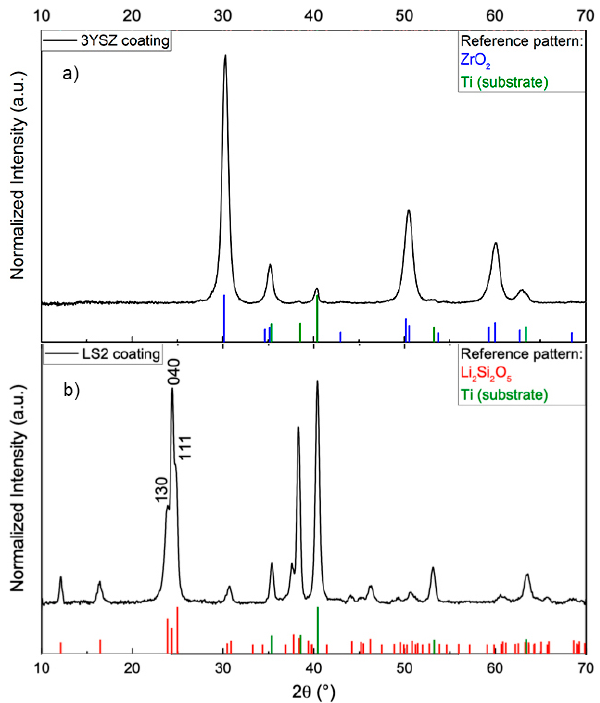
Figure 1. X-ray diffraction ( XRD) spectra of coated surfaces: ( a ) yttria-stabilized zirconium oxide coating on titanium alloy (Ti-3YSZ); ( b ) lithium disilicate coating on titanium alloy (Ti-LS2).